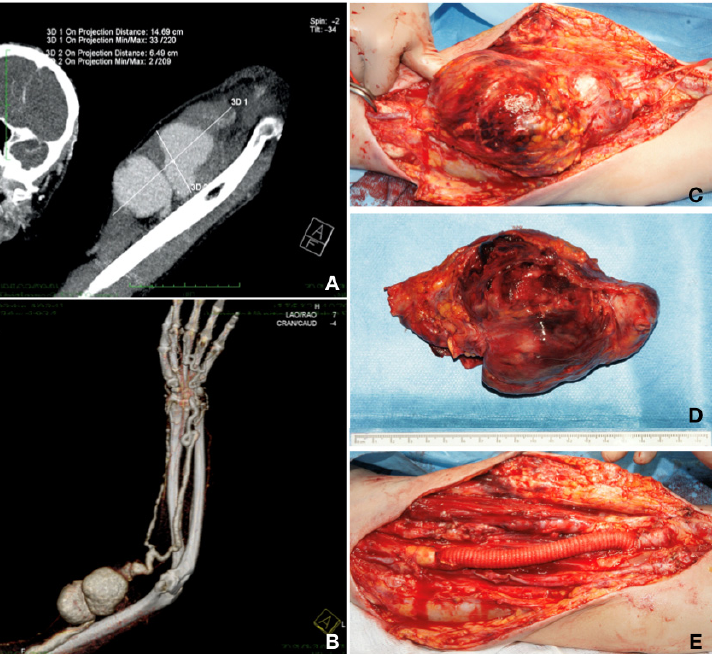
Figure 3. ( A , B ) MIP thin collection and volume rendering technique (VRT) CT-Angio showing the 2D dimensions of the giant aneurysm. On the VRT image, one can observe the bad quality of the radial artery and the calcified aspect of both run-off vessels distal to the aneurysm. ( C ) Intraoperative image with the aneurysm dissection. ( D ) Resected aneurysm with mural thrombosis. ( E ) Vascular reconstruction with 10 mm Dacron graft interposition and spatulated, end-to-end anastomosis with Prolene 6.0 continuous sutures (personal collection).